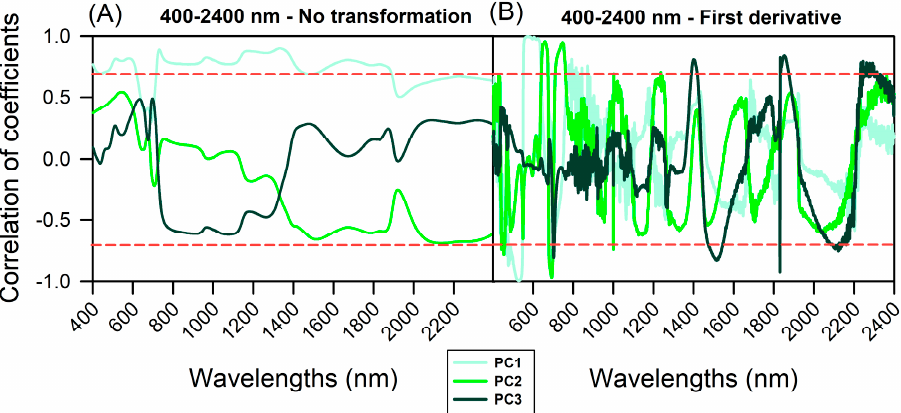
Figure 4. Correlation of coefficients associated with PC1–PC3 (light to dark green lines). ( A ) 400–2400 nm data not transformed. ( B ) 400–2400 nm to first derivative. The red line indicates − 0.70 and +0.70 correlation of